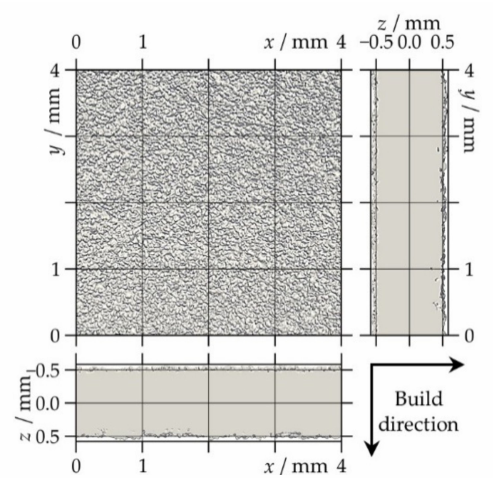
Figure 1. Three orthogonal views of the volume of interest for the X-ray micro-computed tomography data analysis of a laser-sintered polyamide 12 sheet generated with eight layers. The arrows indicate the build direction that corresponds to the positive z -direction in the two lateral